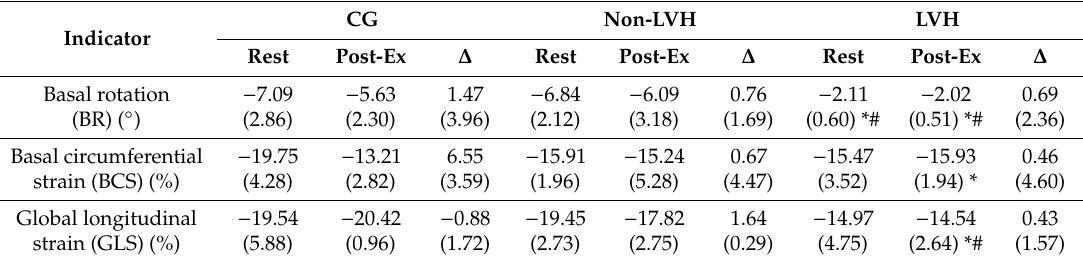
Table 3. Basal rotation absolute value (BR) and relative changes of basal circumferential strain (BCS) and GLS at Rest and Post-Ex and the dynamics of changes ( ∆ ) in the athletes with LVH, athletes without left ventricle hypertrophy (non-LVH) and untrained CG.